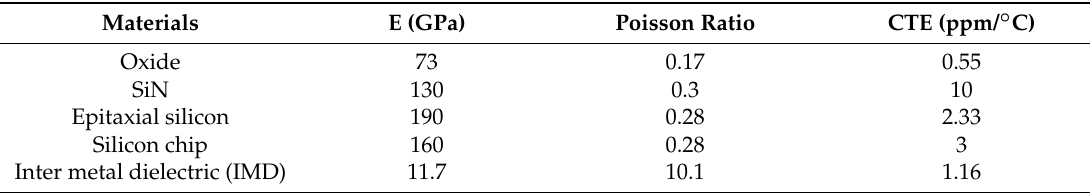
Table 3. List of thin film material